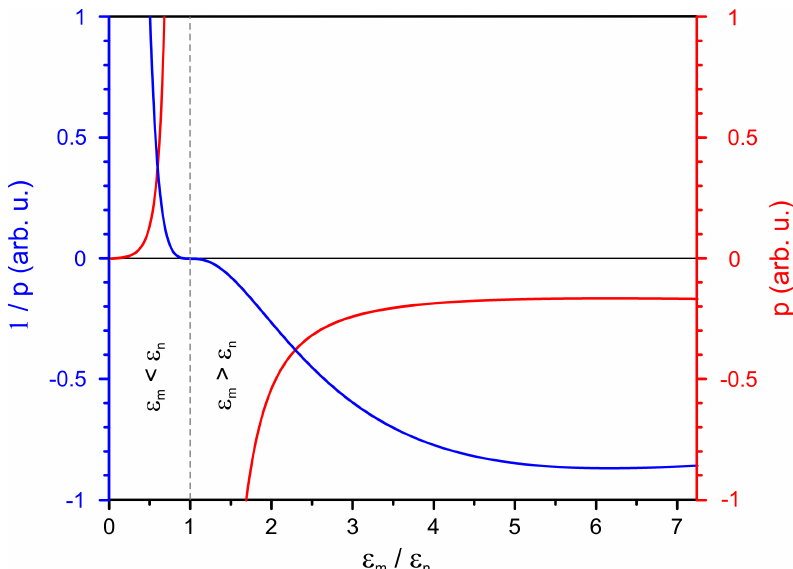
Figure 1. Dependence of the pitch p and of the inverse pitch 1/ p of the cholesteric structure on the ratio of the average susceptibility of the nematic host phase ε m and the susceptibility of the nanoparticle ε n